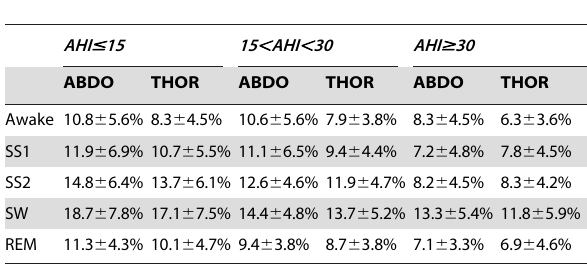
Table 5. Percentage of coordination for different AHI groups and sleep stages using abdominal (ABDO) and thoracic (THOR) signals.